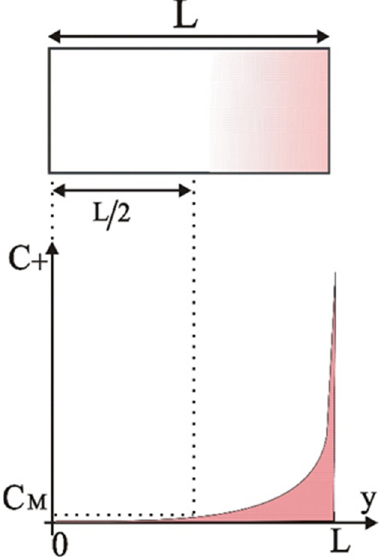
Figure 3. Change of toxin concentration C + across the duct width L, supposing that it has positive